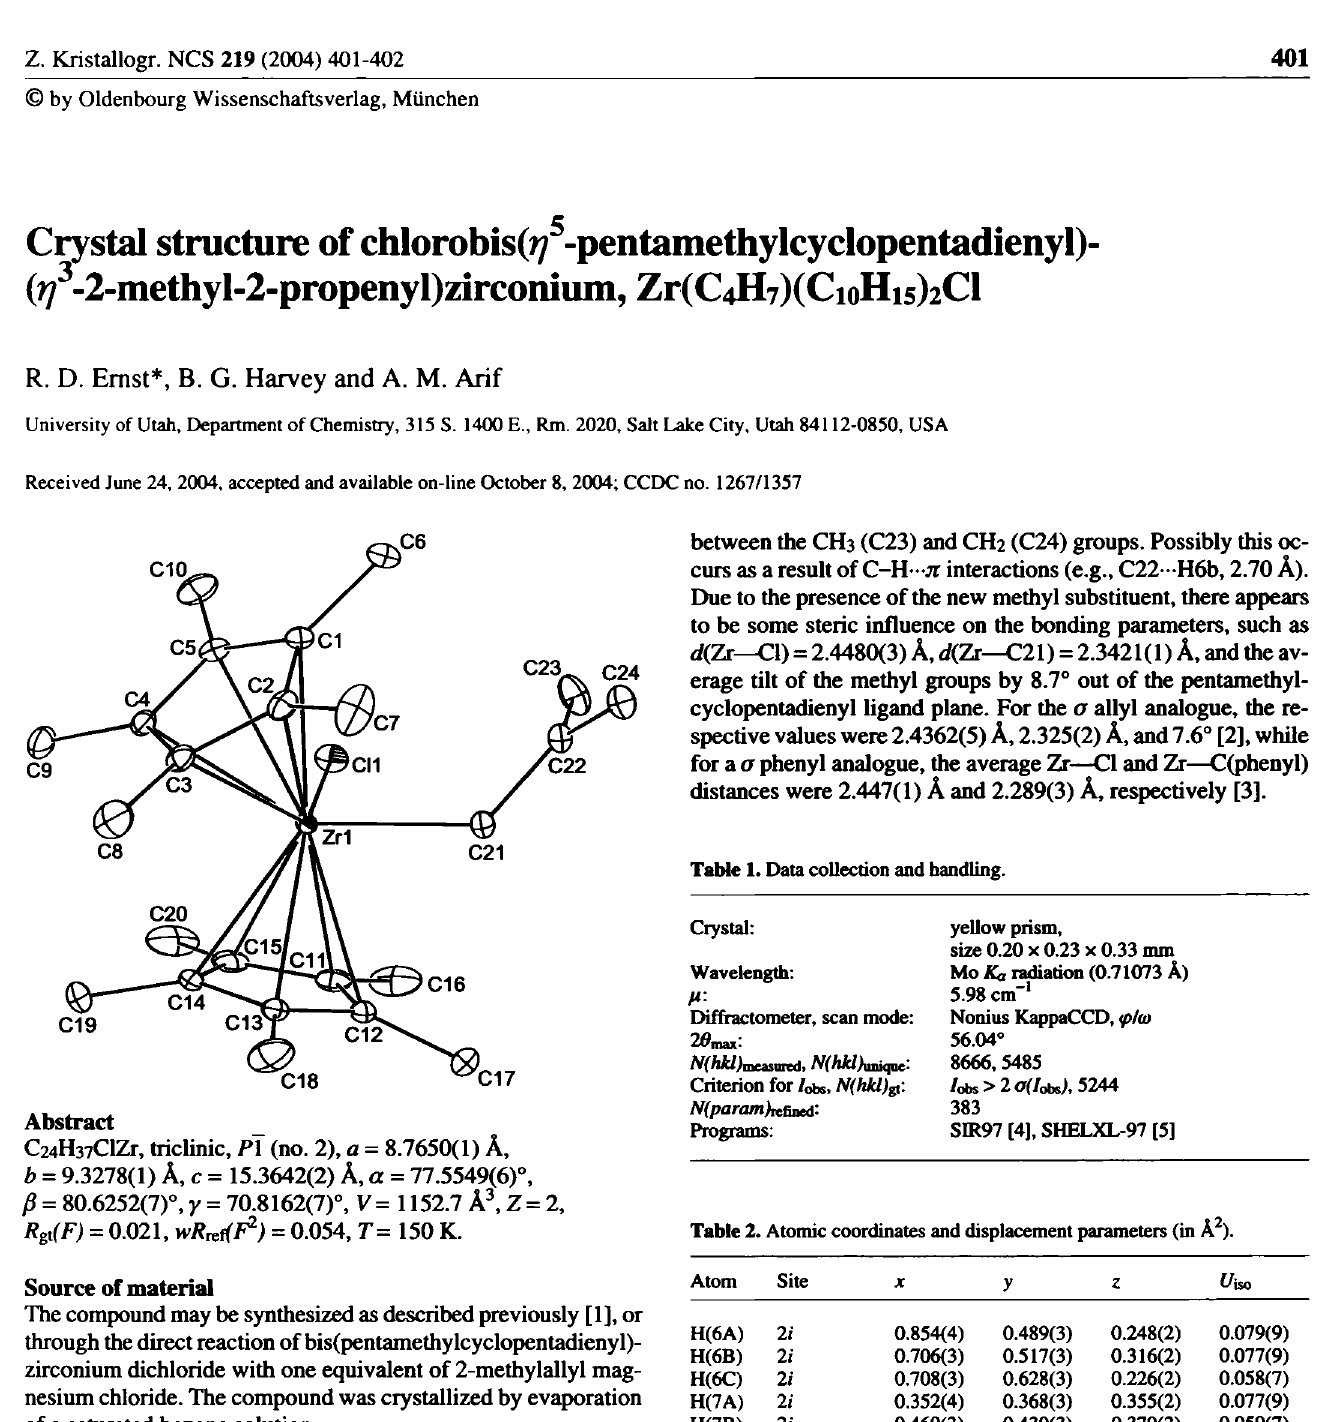
Table 2. Atomic coordinates and displacement parameters (in A 2